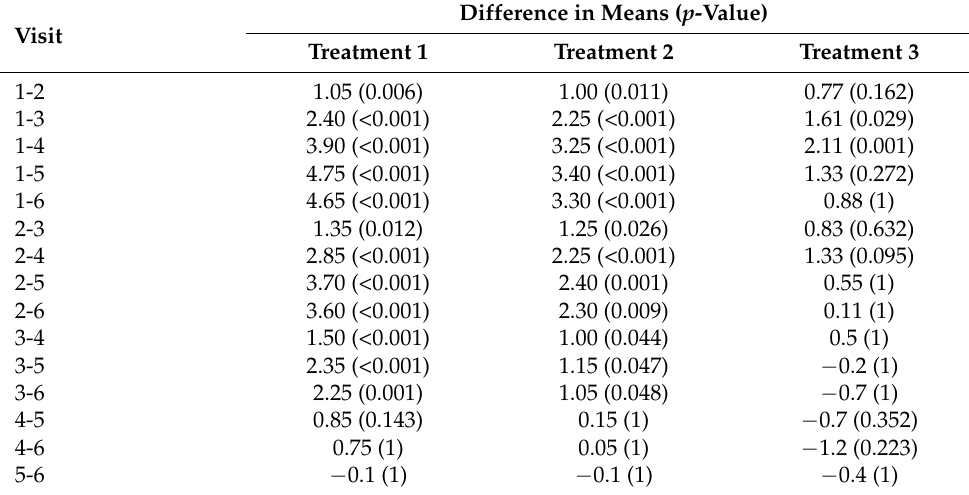
Table 3. Differences in means and p -values between the treatment groups at each of the visits.